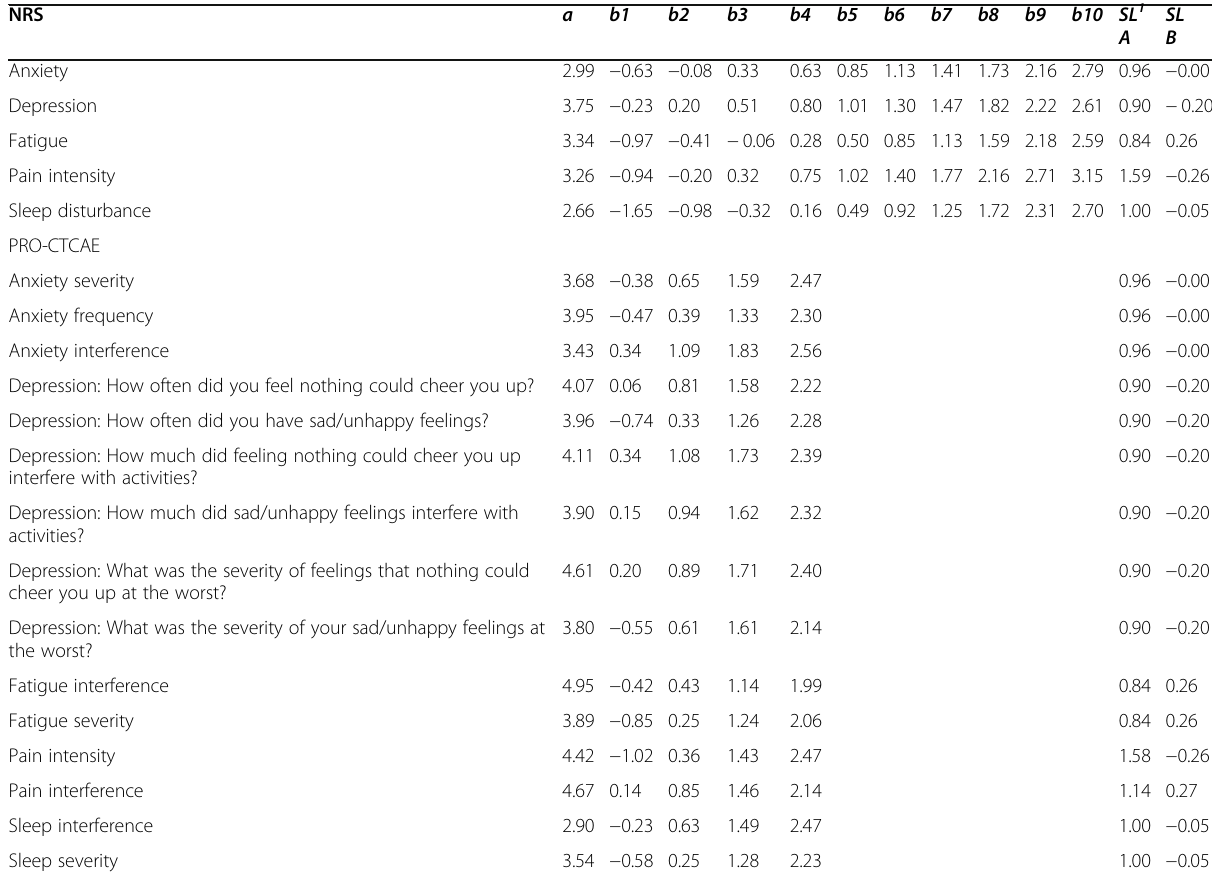
Table 6 Item parameters of the non-PROMIS items after Stocking-Lord linking NRS